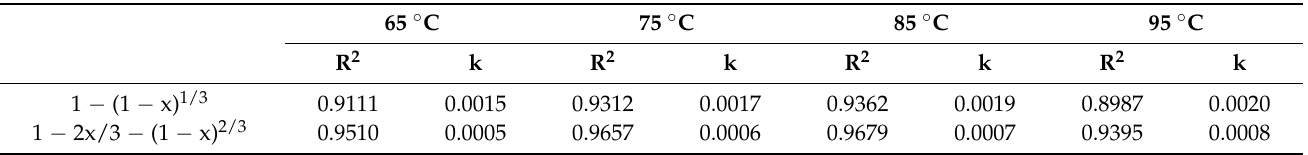
Table 5. The G(a)-t correlation coefficient obtained from the linear fit of the Al 2 O 3 leaching rate of the